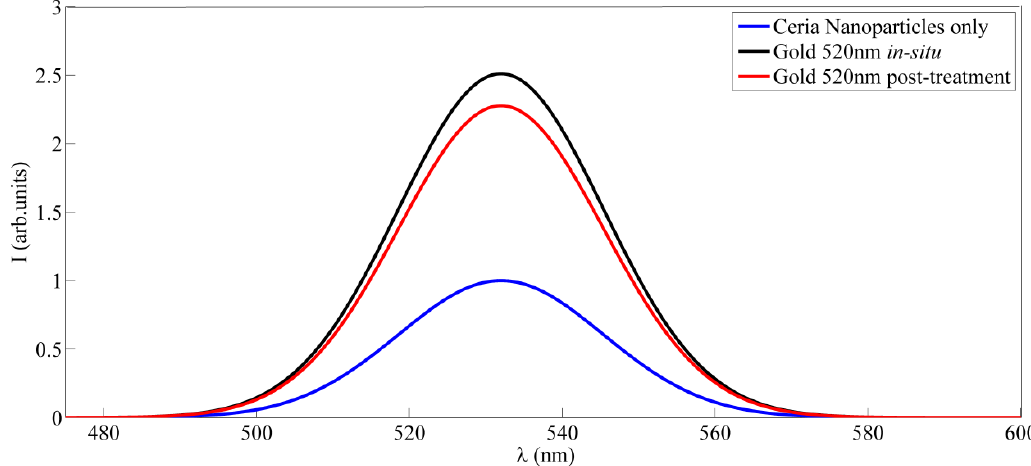
Figure 2. Fluorescence emission of gold-ceria nanoparticles in both cases of in-situ and post-synthesis addition.